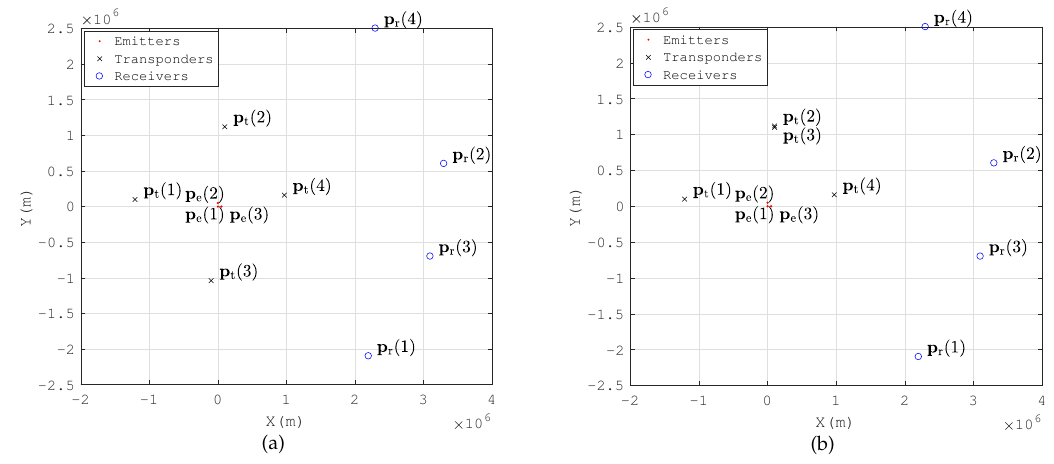
Figure 3. Layouts of the numerical examples. ( a ) Layout A ( b ) Layout